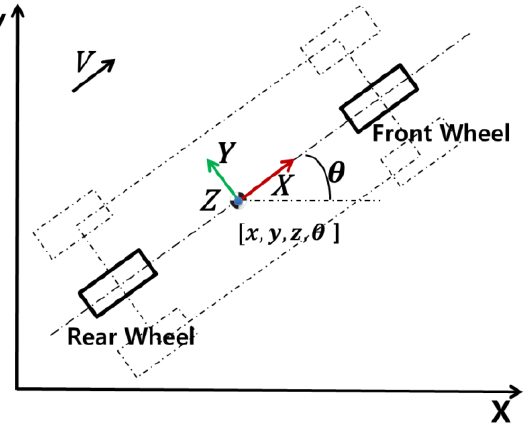
Figure 1. Vehicle state of the particle filter.